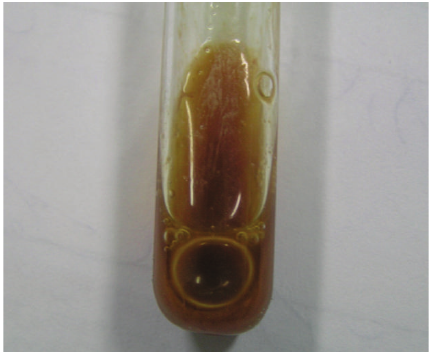
Figure 1: Golden-brown fluid drained from the cyst during surgery.